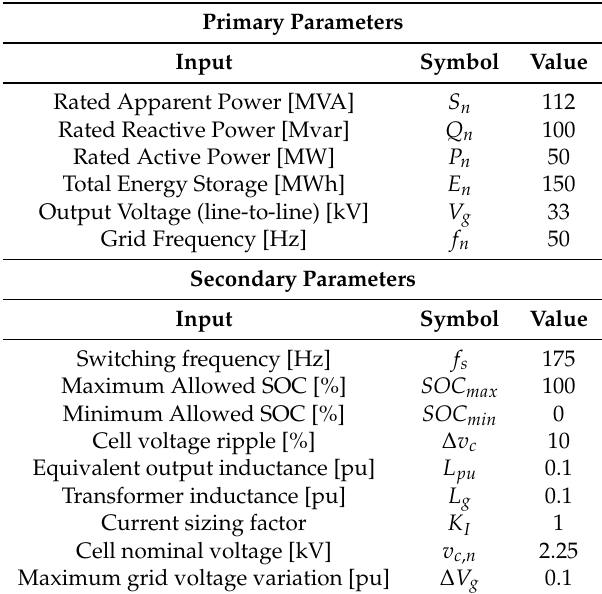
Table 1. ES-STATCOM technical specifications.